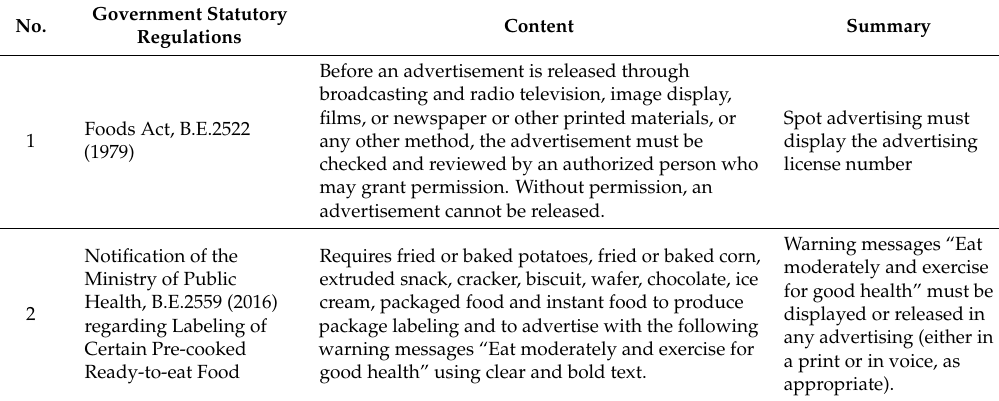
Table A1. Overview of government statutory